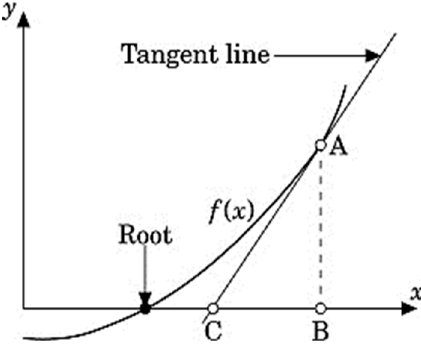
Figure 1. Newton–Raphson method [12]. The copyright © 2014 Elsevier Inc.